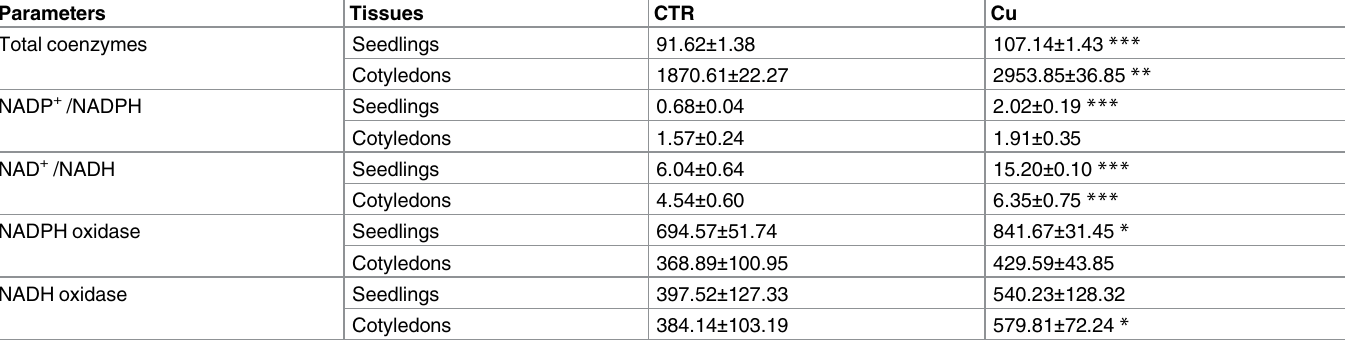
Table 4. Activitiesof NAD(P)Hoxidasesand redox ratios of coenzymesin the seedlings (3 days-old) and the cotyledons (9 days-old) of germinated bean seeds in the presence of H 2 O (CTR) or 200 μ M Cu.